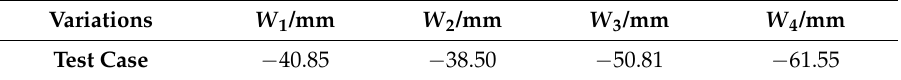
Table 5. The variations of the design variables compared to the prototype model (1:1). Variations